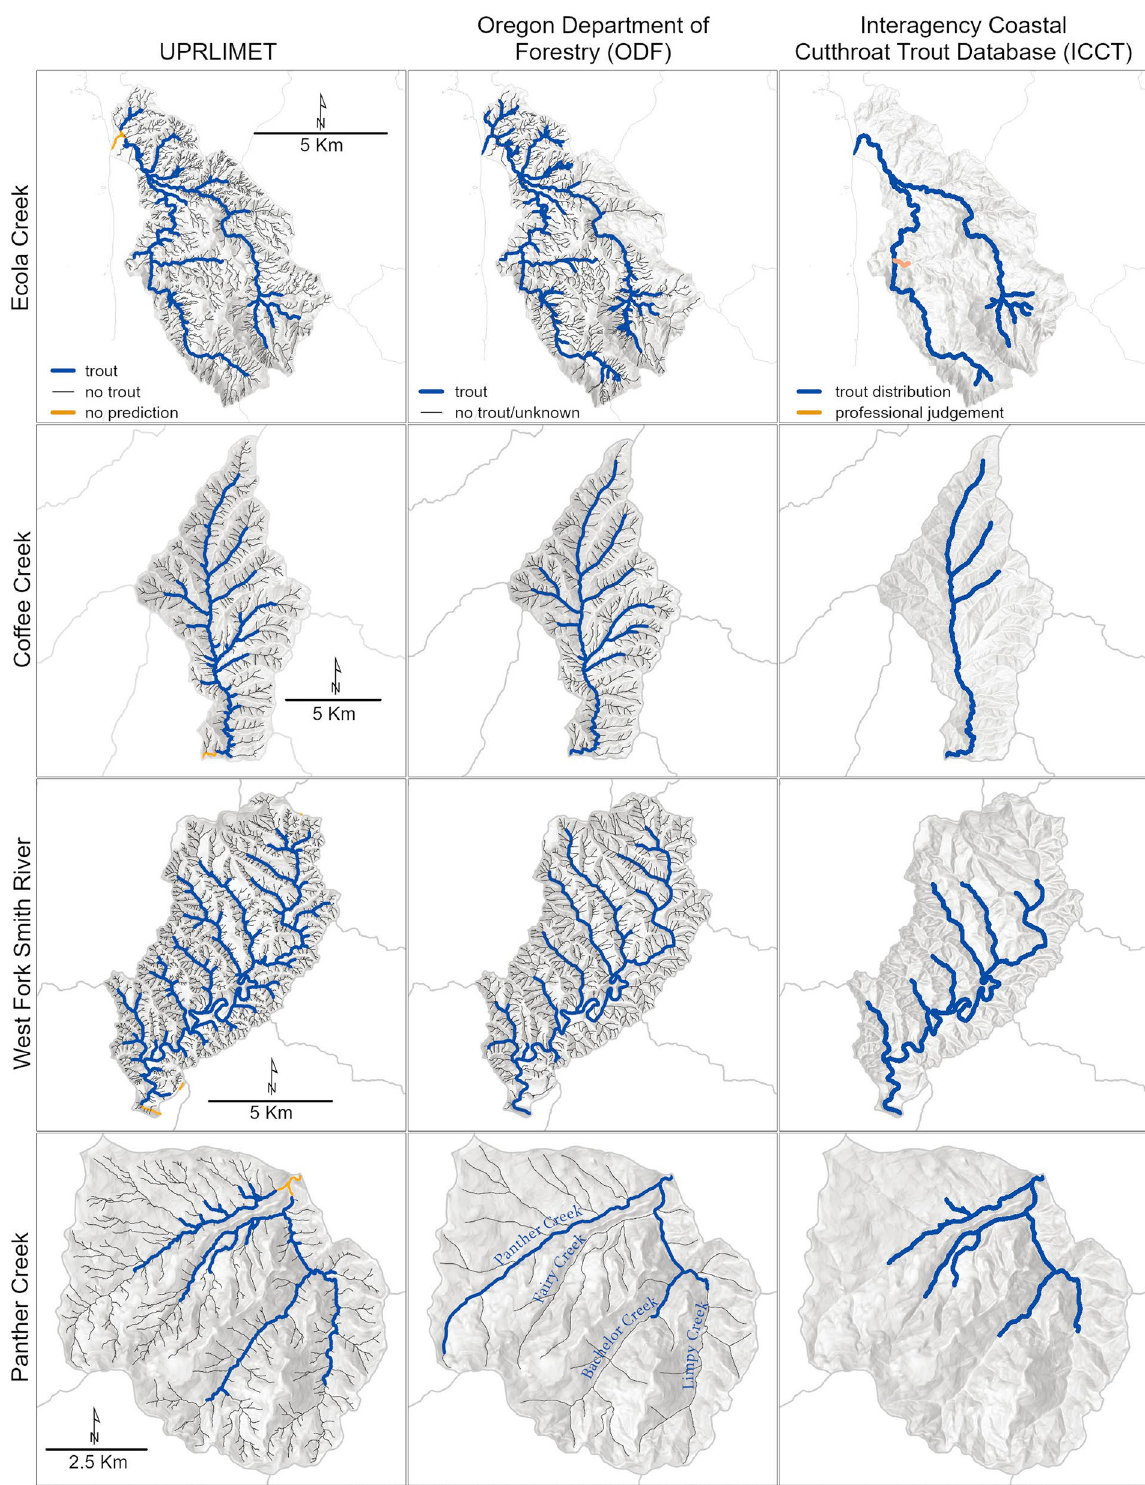
Figure 5. Examples of fish distributions in four HUC12 sub-watersheds, including Coffee Creek [Rogue River], Ecola Creek [Coast Range], and Panther Creek [North Umpqua River], and West Fork Smith River [Umpqua River]. Left panel shows predictions of presence and absence of trout using UPRLIMET. Middle panel shows trout occurrence and habitat distributions from Oregon Department of Forestry (ODF). Right panel shows trout occurrence distributions from the Interagency Coastal Cutthroat Trout (ICCT) database. The flowlines vary across the three databases owing to differences in hydrography associated with each